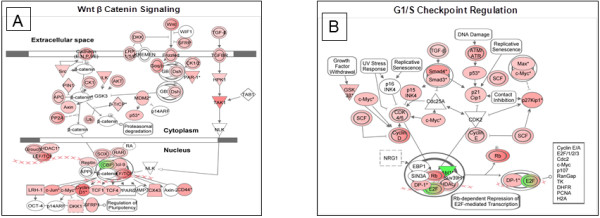
Microarray analysis also indicated an increase in Wnt signaling and cell cycle regulation in women. (A) Increased turnover of epithelial cells is associated with an increase in expression of genes in the Wnt β Catenin signaling pathway with downstream nuclear effectors such as SOX, HDAC1. (B) A compensatory increase in cell cycle regulation via the G1/S Checkpoint was also observed at the transcriptional level. (Red: Increase in expression, Green: decrease in expression).